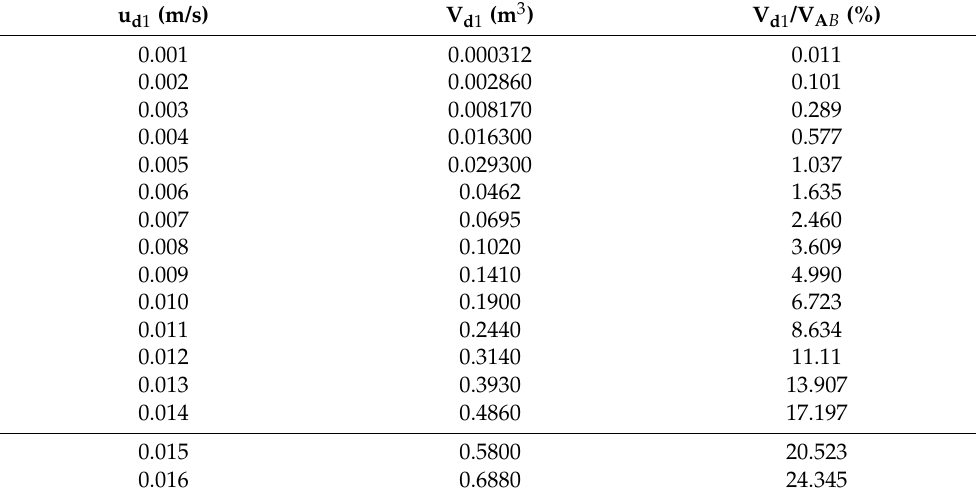
Table 10. Volume fraction of dead region in the receiving chamber under different critical velocities. u d 1 (m/s) V d 1 (m 3 )